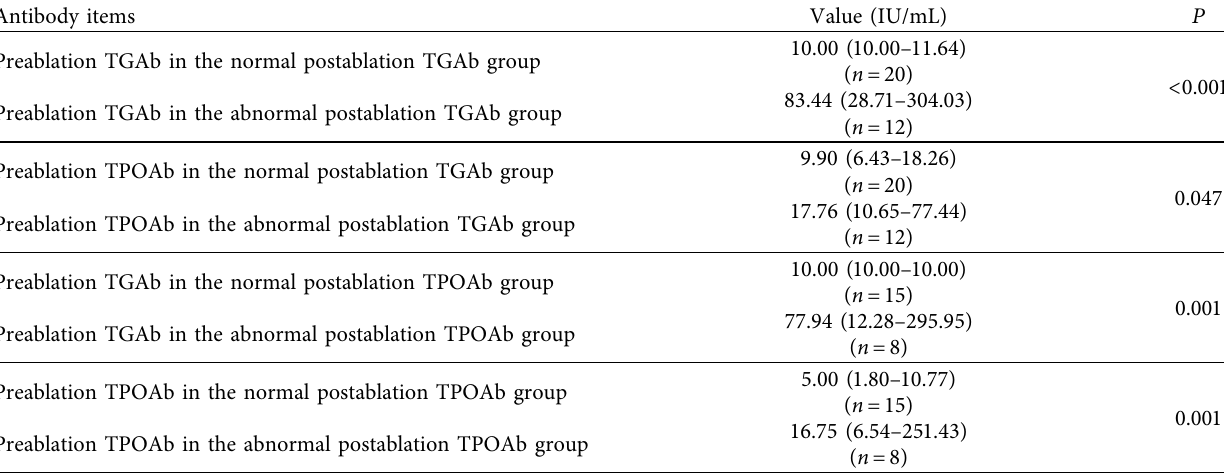
Table 4: Preablation and postablation antibody values in different antibody groups after microwave ablation of benign nodules. Antibody items Value (IU/mL) Preablation TGAb in the normal postablation TGAb